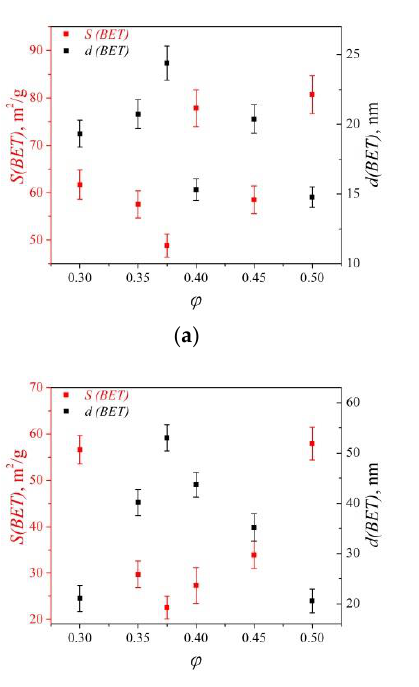
Figure 3. Micrographs of the Y 2 O 3 powders obtained by the SHS method from precursors with different compositions with and without LiF.